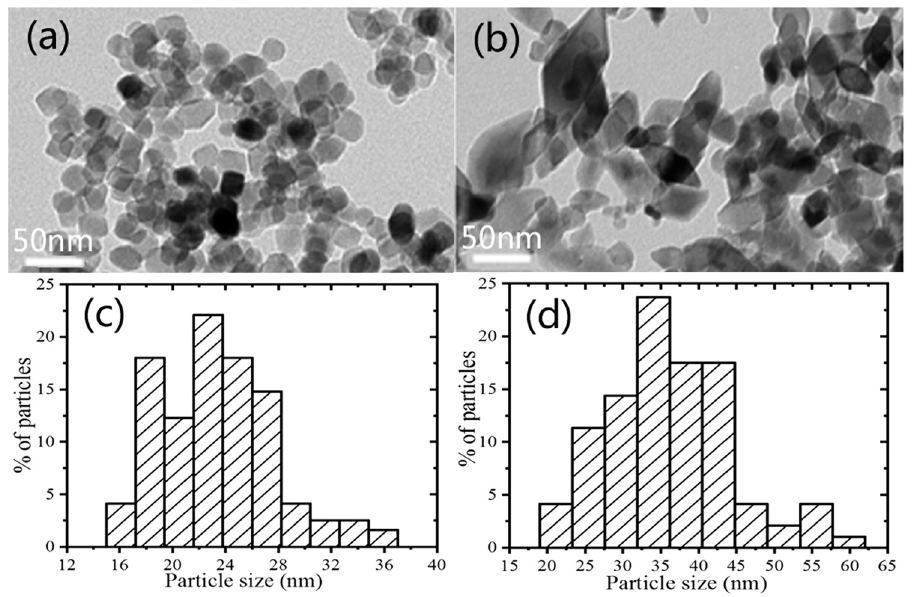
Figure 4: TEM pictures of TiO 2 synthesized at 30 MPa and di ff erent times ( a ) 5 min ( b ) 10 min and their corresponding size distribution (